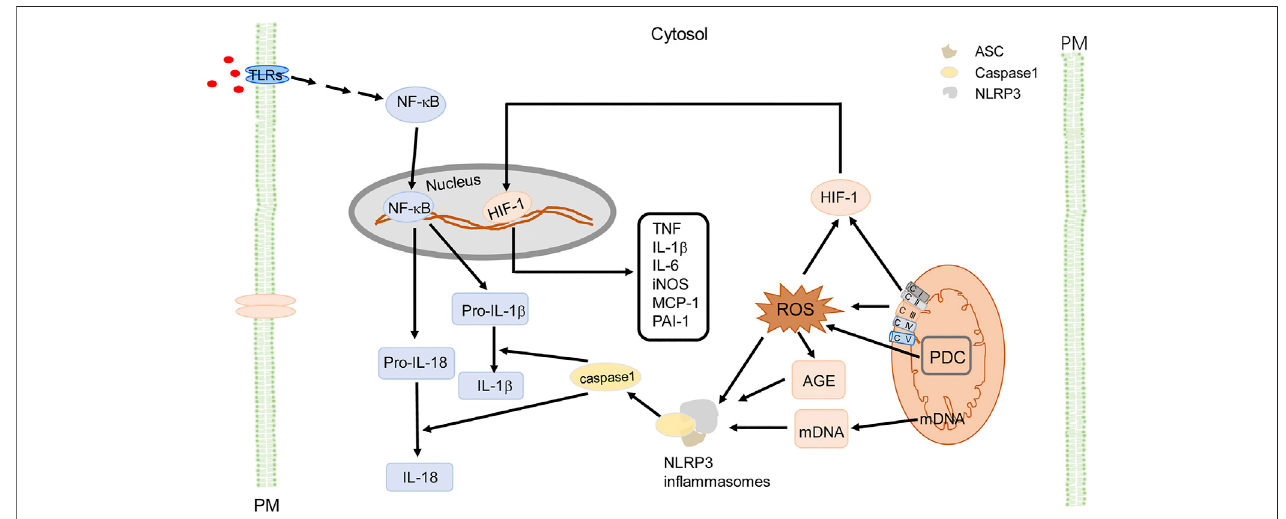
FIGURE4| Mito-ROSsignalingandcellulareffectsinMetS.Mito-ROS,producedmainlybyETC(mainlyCIandCIII)duringoxidativephosphorylationandenzymes like pyruvate dehydrogenase complex (PDC), provide the signaling to trigger NLRP3 in fl ammasome oligomerization with adaptor protein ASC and pro-caspase-1. NLRP3activationcanbeprimedbyTLRs(step1)toactivateNF- κ Boranon-NF- κ Bpathwaytoproducepro-IL-1 β andpro-IL-18.Step2occurswhenactivecaspase-1 cleaves pro-IL-1 β and pro-IL-18 to produce mature cytokines IL-1 β and IL-18. Mito-ROS also induce the formation of AGE, as a DAMP to activate NLRP3; mDNA also activates NLRP3 in fl ammasomes as a DAMP. Additionally, Mito-ROS trigger responses to hypoxia, activating HIF-1, and upregulate proin fl ammatory genes like TNF,IL-1 β ,IL-6,iNOS,MCP-1,andPAI-1.Thesecytokinesactivatetheinsulinsignalingpathwayandinducelocalandsystemicinsulinresistance(notshown).PDCisan importantsourceofmitochondrialROS,resultinginactivationofNLRP3in fl ammasomesasaDAMP.Forsimplicity andclarity,onlypartofsignalingandcellulareffectsin macrophages are illustrated. AGE, advanced glycation end-products; ASC (apoptosis-associated speck-like protein containing a CARD), CI, ETC complex I; CII, ETC complex II; CIII, ETC complex III; CIV, ETC complex IV; CV, ETC complex V; ETC, electron transport chain; IL, interleukin; iNOS, inducible nitric oxide synthase; PM, plasma membrane; NF- κ B, nuclear factor kappa-light-chain-enhancer of activated B cells; PAI-1, plasminogen activator inhibitor 1; PDC, pyruvate dehydrogenase complex; TNF, tumor necrosis factor; TLR, Toll-like